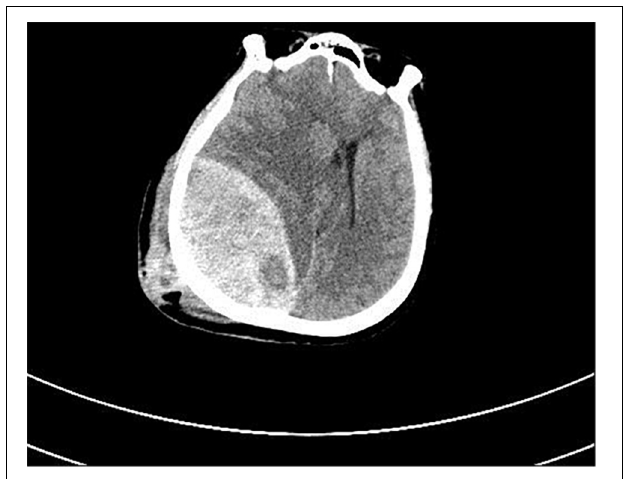
FIGURE 1 | The CT examination of one patient with cerebral contusion and laceration with intracerebral hematoma.